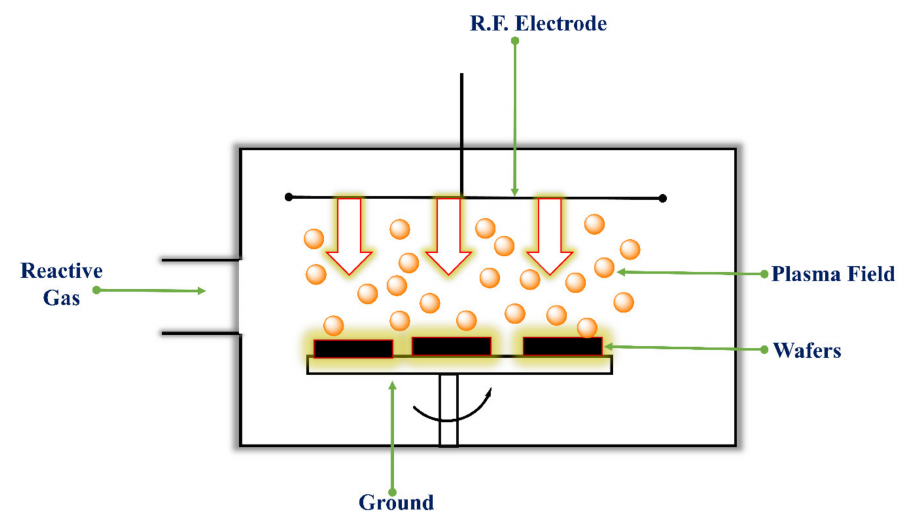
Figure 12. Planar plasma etches configuration method. The wafers are held on a grounded chuck close to the RF electrodes. Reactive gas introduced in the chamber is ionized, and the ions help in material removal [189]. (Reprinted from Ref. [189]).